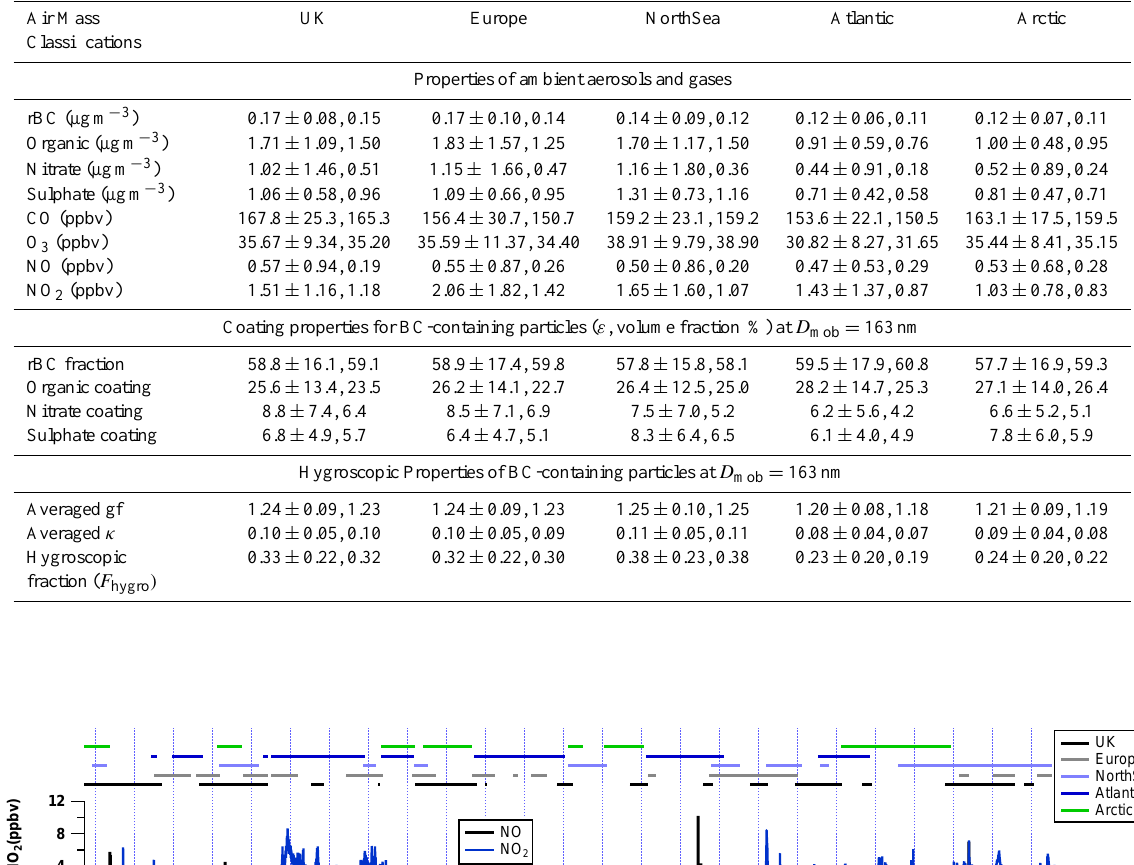
Table 1. Average values of properties of ambient aerosols, BC-containing particles and hygroscopicity of BC-containing particles. The data in each table cell represents the mean ± standard deviation, median.